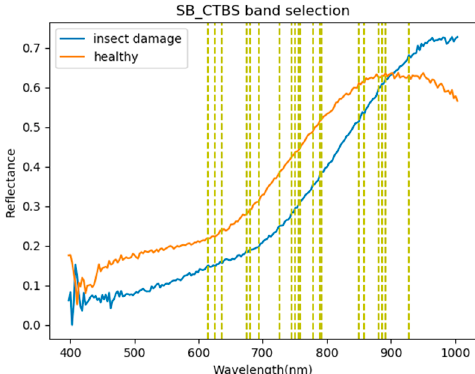
Figure 14. Visualization of the SB_CTBS band selection results. The first five bands are 858, 850, 927, 674, and 891 nm.